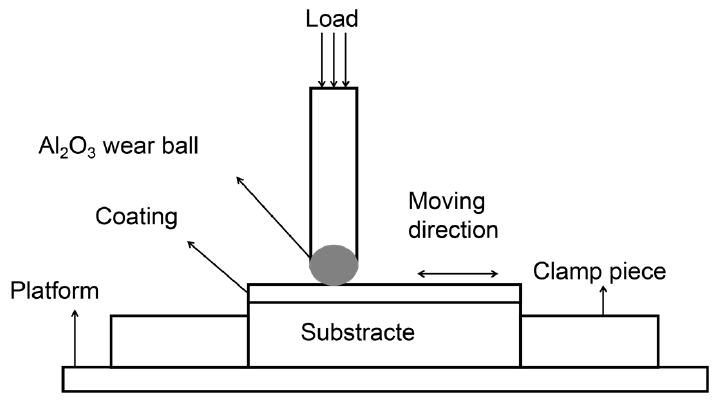
Figure 3. Schematic diagram of wear test process.